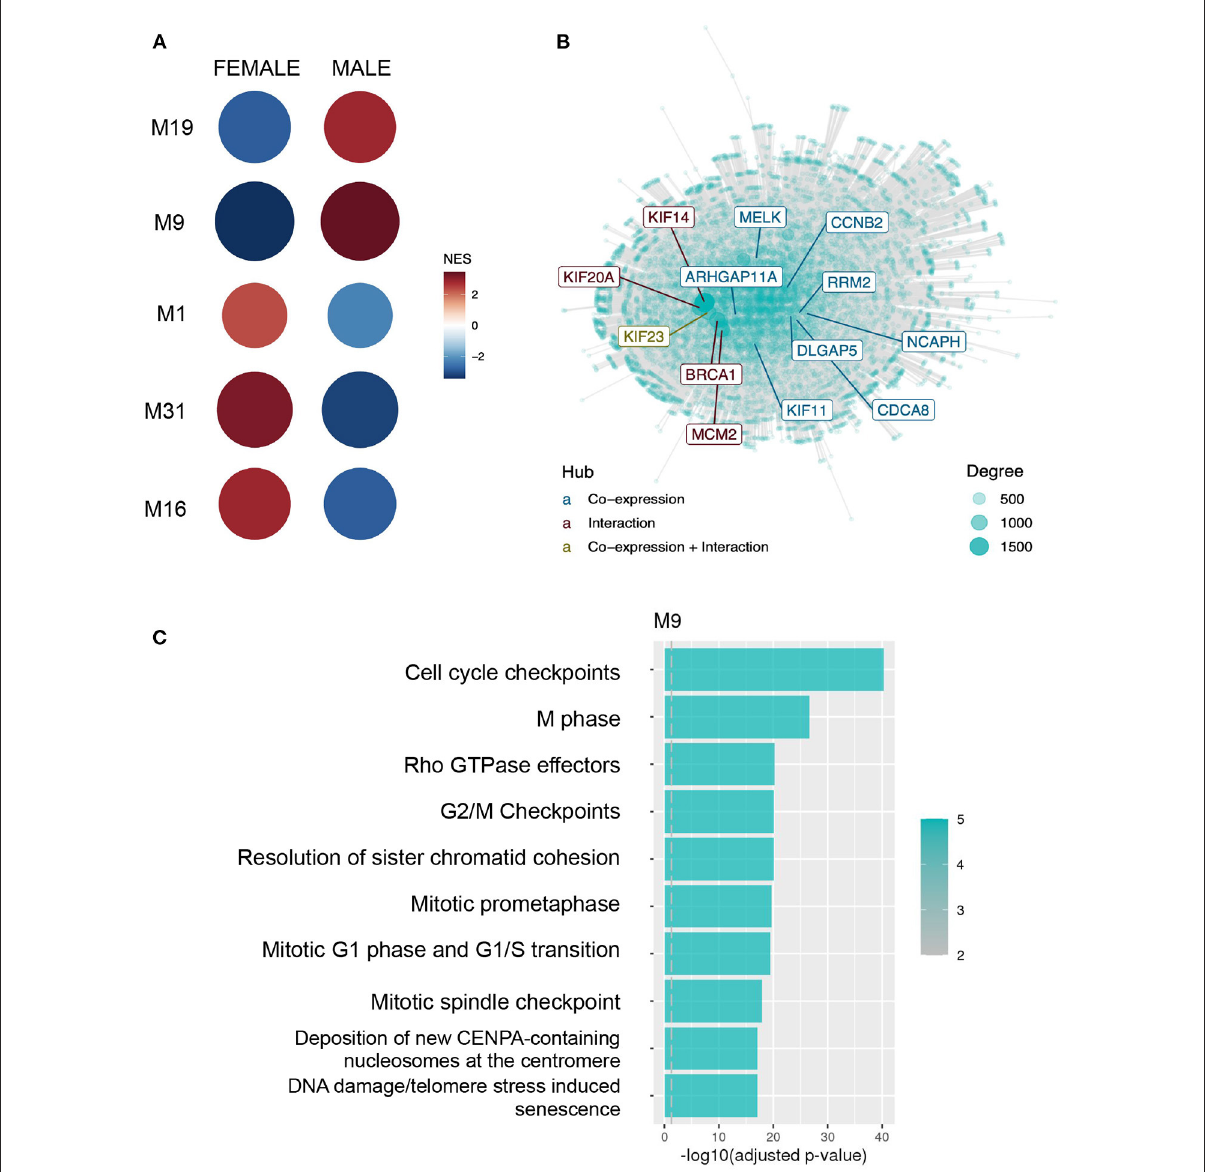
FIGURE2 Normalized expression values from males and females were submitted to co-expression analysis with CEMiTool, demonstrating different patterns of expression associated with particular biological functions. (A) GSEA demonstrating each module activity for males and females. Circle color and size represents the Normalized Enrichment Score (NES). (B) Integrated network with interaction data for M9, with hub genes highlighted. (C) Over-representation analysis of genes from module M9 using pathways from the Reactome